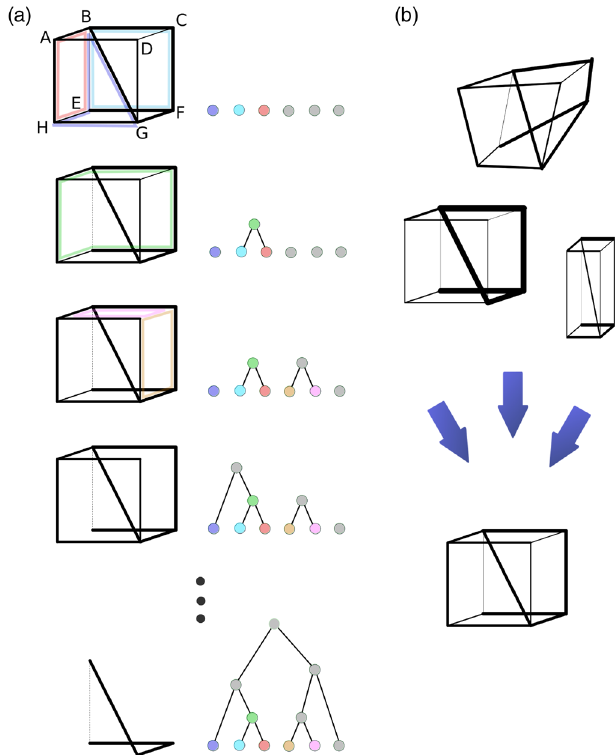
FIG. 5. (a) Schematic of the cycle-coalescence algorithm applied to a simple 3D graph. The cycle coalescence proceeds from top to bottom. At each step, the next weakest link is cut, and the two cycles that bordered that link coalesce into one. On the right, we show the characteristic tree being progressively built, with each node representing a cycle in the network. To aid the eye, some cycles that participate at that stage of the algorithm are highlighted in color, and the corresponding nodes of the characteristic tree are correspondingly color-coded. (b) Schematic of degenerate graphs that produce the same characteristic tree. The cycle coalescence is blind to geometry and exact weights of